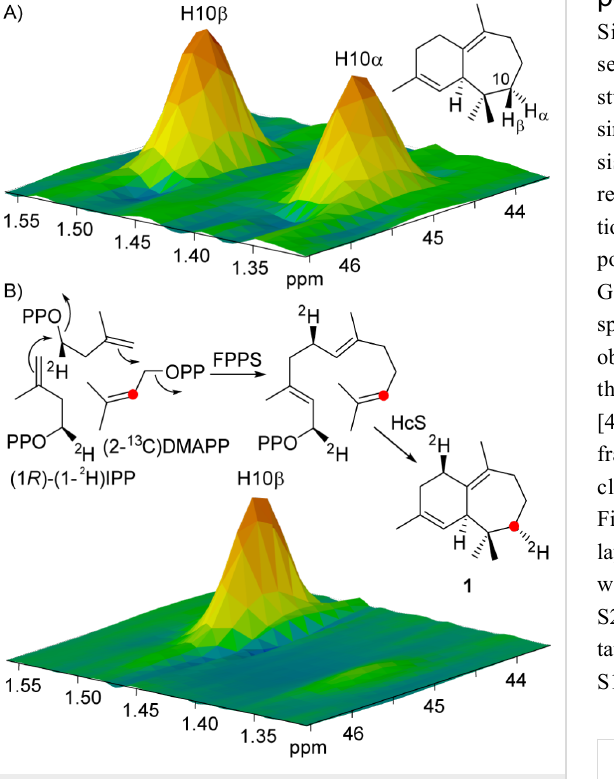
Figure 9: Stereochemical course of the 1,3-hydride shift at C-10 in 1 . Partial HSQC spectra of A) unlabelled 1 and B) labelled 1 arising from the incubation of (1 R )-(1- 2 H)IPP and (2- 13 C)DMAPP with FPPS and HcS. Red dots indicate 13 C-labelled carbon atoms.